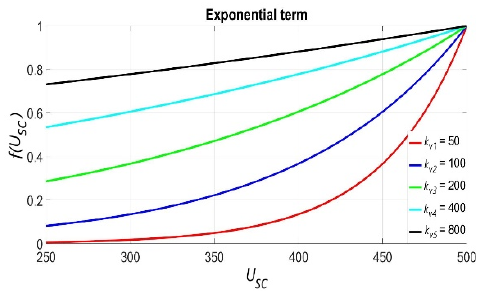
Figure 3. Value of the exponential function from (10) depending on the parameter k v .